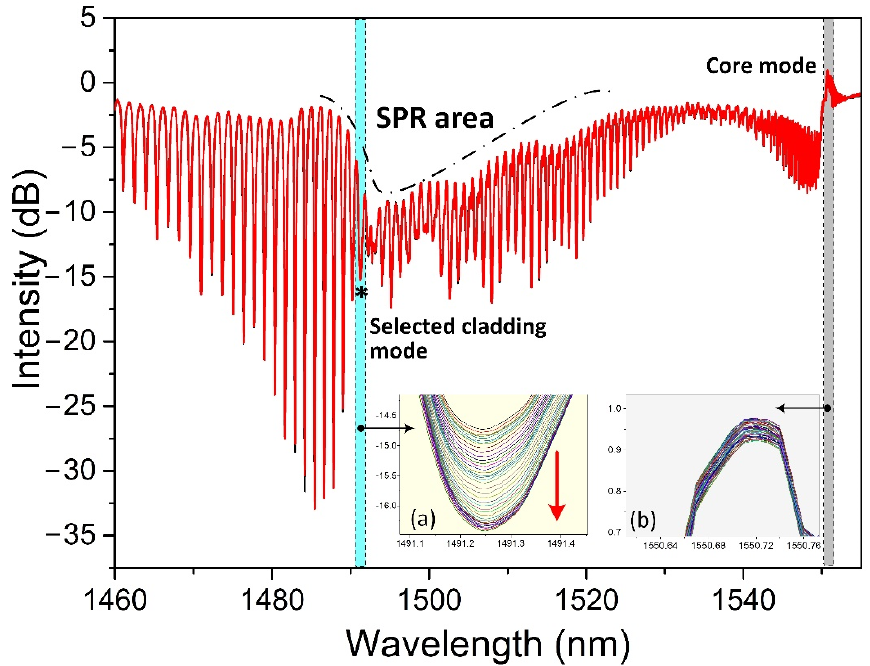
Figure 4. A measured spectrum of the biosensor. Insets ( a ) and ( b ) are, respectively, the responses of the selected cladding mode and core mode when the biosensor was used for measuring CaM at a concentration of 1 µM. concentration of 1 µ